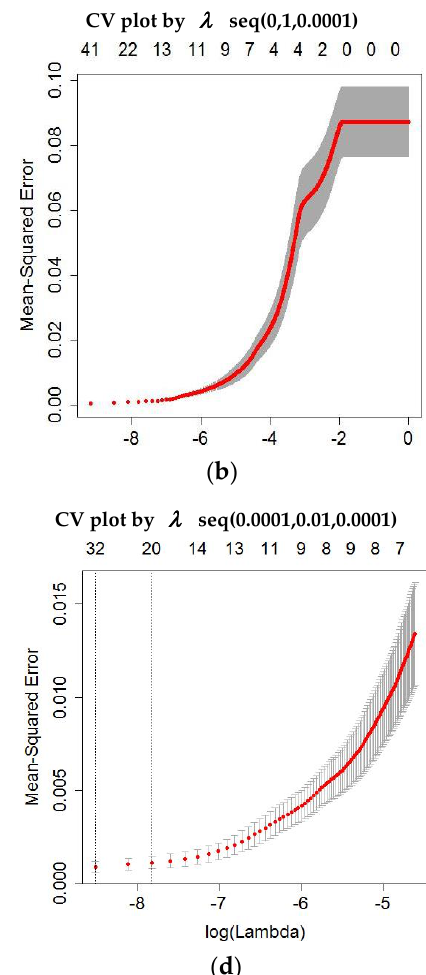
seq(0, 1, 0.0001), ( c ) seq(0.0001, 0.1, 0.0001), and ( d ) seq(0.0001, 0.01, 0.0001). The red dotted line is the CV curve and the error bars along the λ sequences are upper and lower